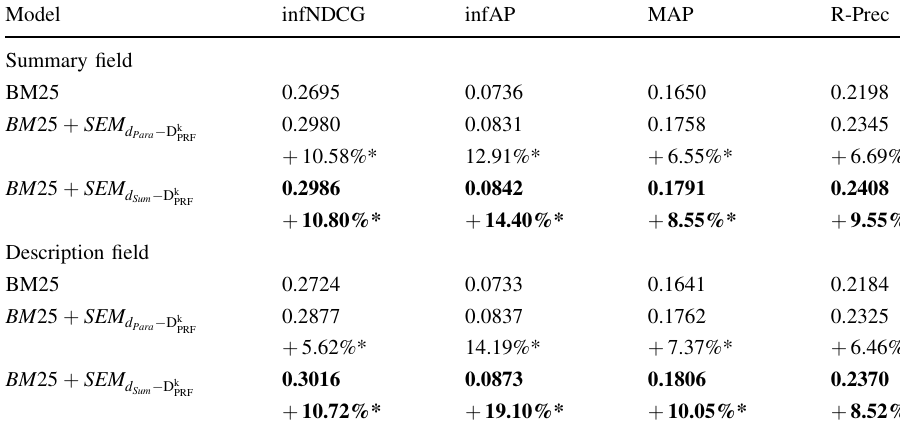
Table 3 Evaluation results on the TREC 2015 CDS